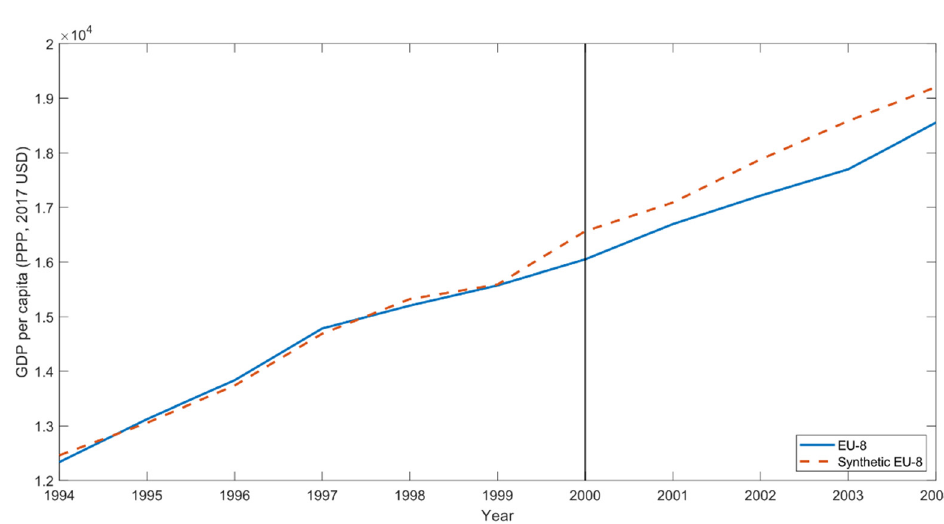
Figure 3. In-time placebo: GDP per capita difference between EU-8 and synthetic EU-8.